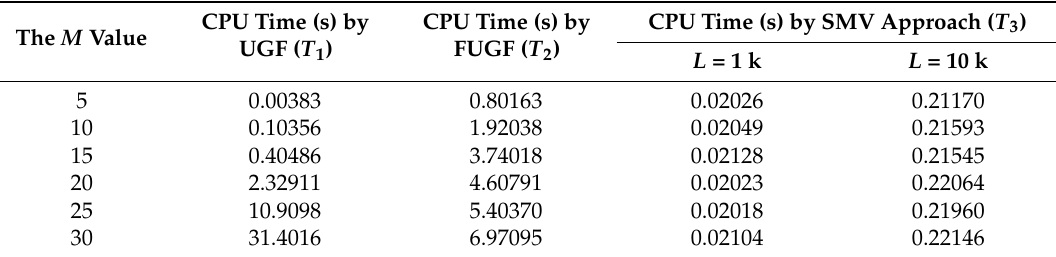
Table 1. Efficiency comparison for a system of model I with six